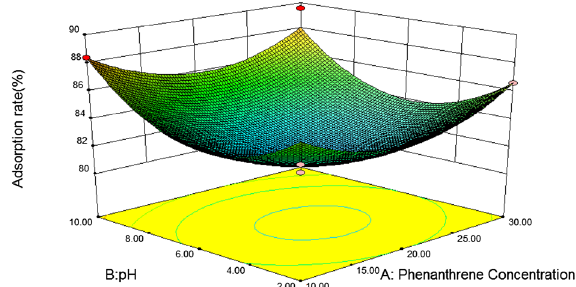
Figure 5. Effects of initial phenanthrene concentration and pH on adsorption rate of loess.